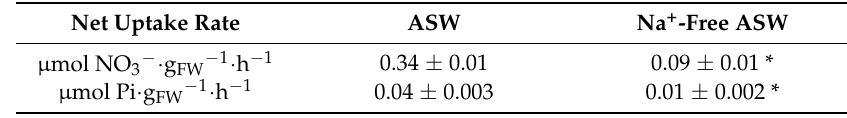
Table 1. NO 3 − and Pi net uptake rates in leaves of P. oceanica . N- or P-starved plants were incubated in artificial seawater (ASW) containing 500 mM NaCl and Na + -free ASW in which NaCl was substituted by 0.8 M Sorbitol, in the case of NO 3 − depletion assays, or 0.5 M Cl-choline in the case of Pi depletion. Net uptake rates were calculated as the slope of the linear phase of NO 3 − and Pi depletion curves within the first 24 h after the addition of 100 µ M NO 3 K and 10 µ M PO 4 H 2 K, respectively. Data are mean ± SD of three independents